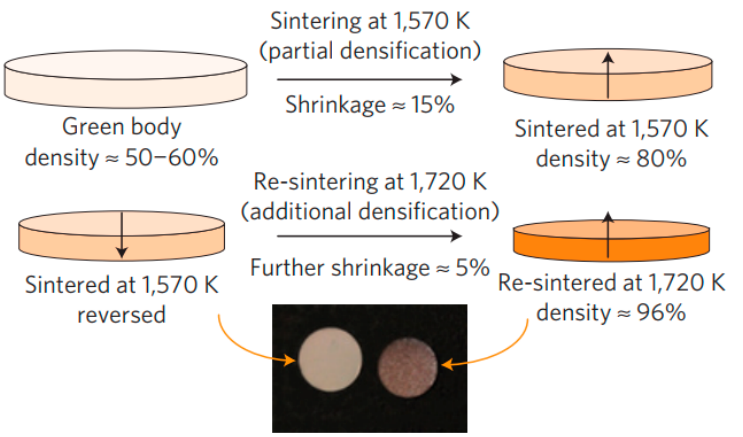
Figure 12. Breaking the macroscopic centric symmetry during sintering at high temperatures. The preferred direction of the polarization depends on the orientation of the sample in the furnace. The sample’s arrow represents the polarization’s preferred direction. Reprinted with permission from [27]. Copyright 2015 Springer Nature.